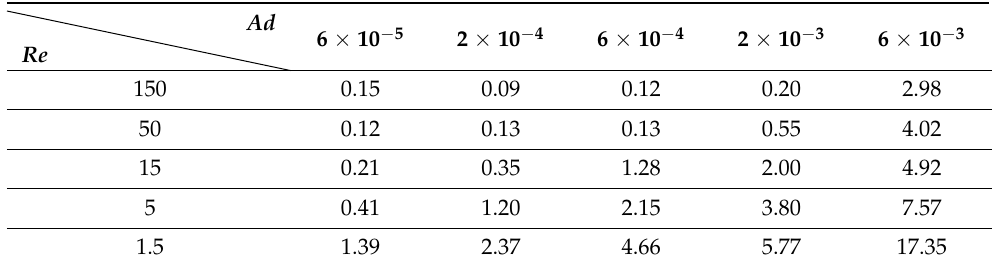
Table 4. Scaled average radius of gyration Rg * for different Reynolds Re and adhesion Ad numbers at a solid particle volume fraction